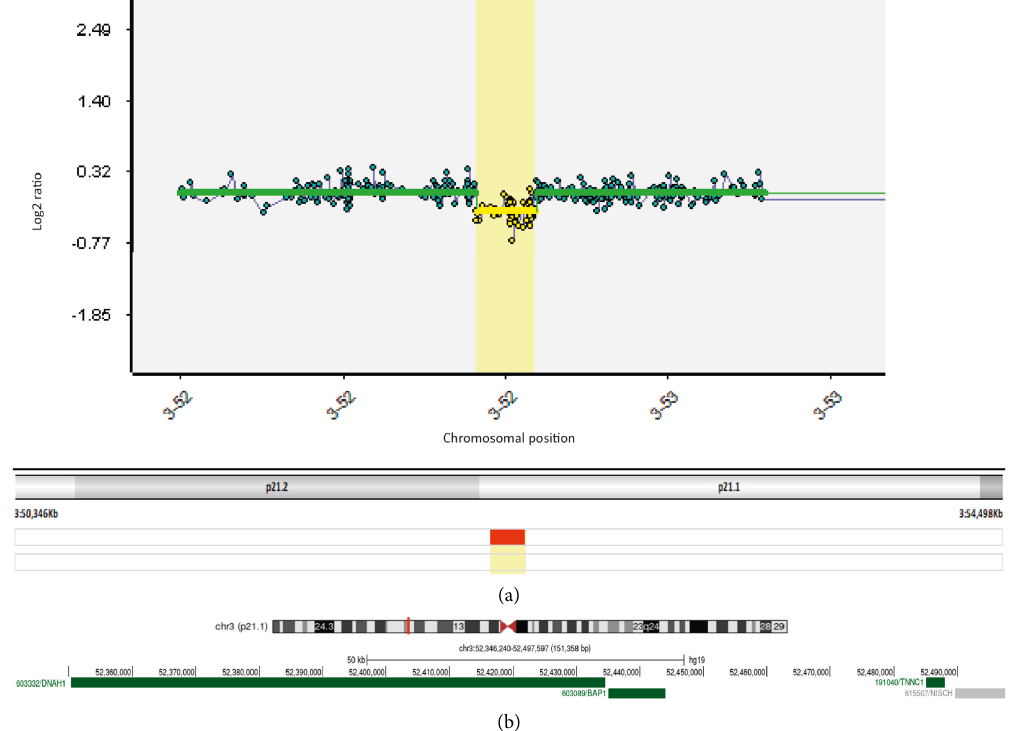
Figure 2: (a) An array profile of the deletion and (b) the breakpoints of the deletion and involved OMIM morbid